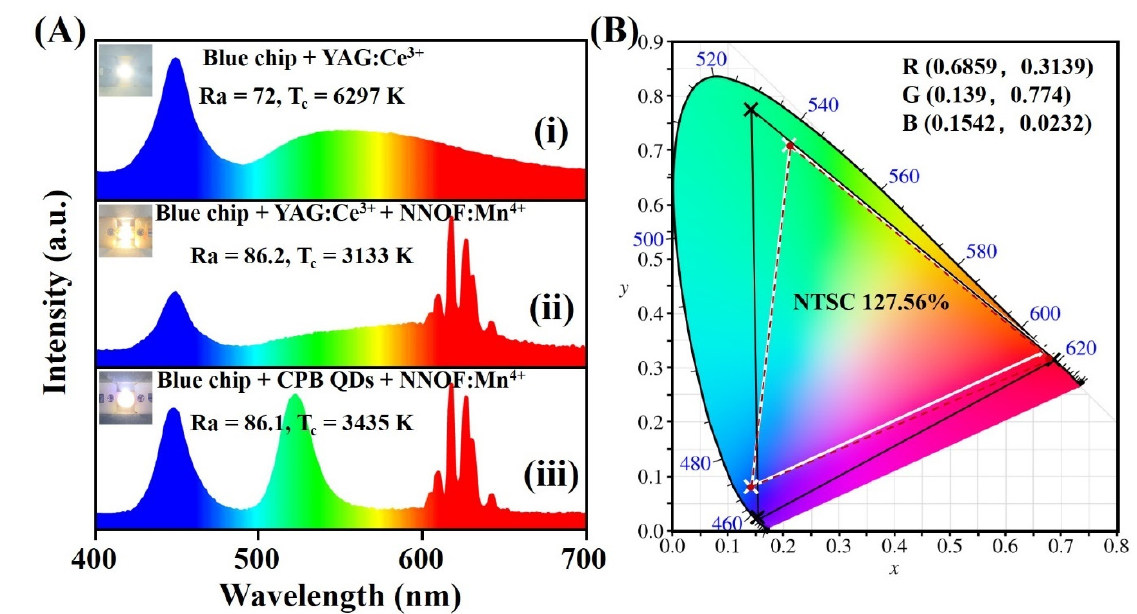
Figure 8. ( A ) Electroluminescence spectra of the WLED fabricated by (i) YAG:Ce 3+ , (ii) the mixture of YAG:Ce 3+ with NNOF:Mn 4+ and (iii) the mixture of CPB QDs with NNOF:Mn 4+ ; insets exhibit the corresponding luminescent images of the packaged WLEDs; ( B ) Color gamut of the NTSC standard (white triangle), color gamut of the prepared NNOF:0.003Mn 4+ phosphor matched with the standard blue and green coordinates defined by NTSC (red dotted triangle) and color gamut of the constructed WLED using CPB QDs and NNOF:Mn 4+ (black triangle).